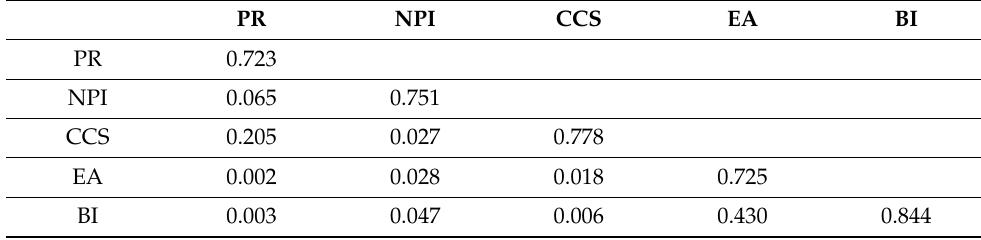
Table 4. AVE and Squared